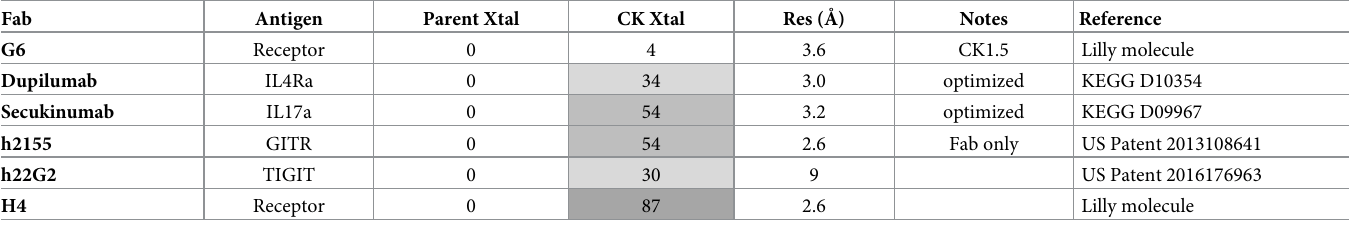
Complexes were screened in two 96-well crystallization screens and scored after 9 days. Number of conditions with crystals of any kind from the parental complex (without crystallization mutations) are indicated in the “Parent Xtal” column. Conditions with crystals from the CK1.0 Fab antigen complex in the column labelled “CK Xtal”. The best diffraction or dataset from these screens or subsequent optimizations is indicated in the “Res”